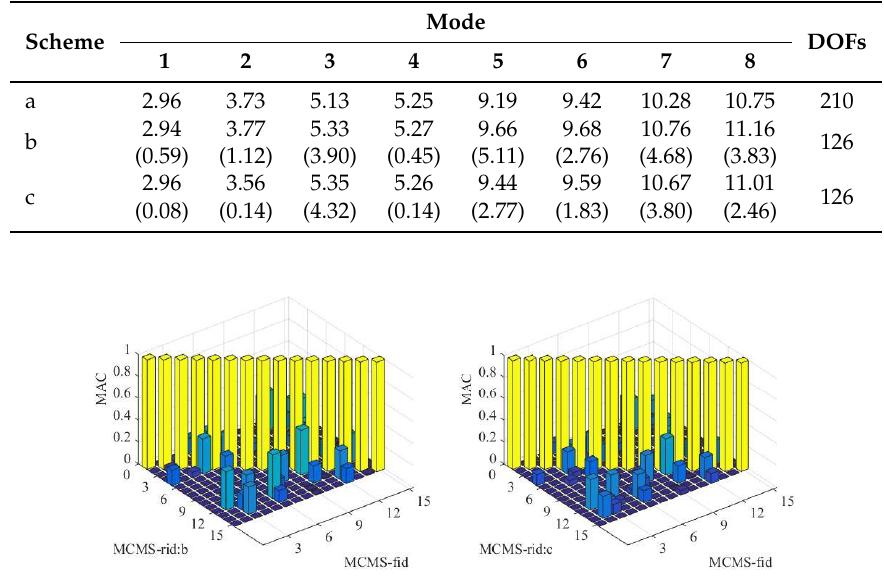
Figure 9. The coupling interface and interpolating schemes. ( a ) the coupling interface; ( b ) scheme with triangular interpolation sub-regions; ( c ) scheme with quadrangle and triangular interpolation sub-regions. Table 3. The first eight natural frequencies of the beam (Hz) and relative error (%).